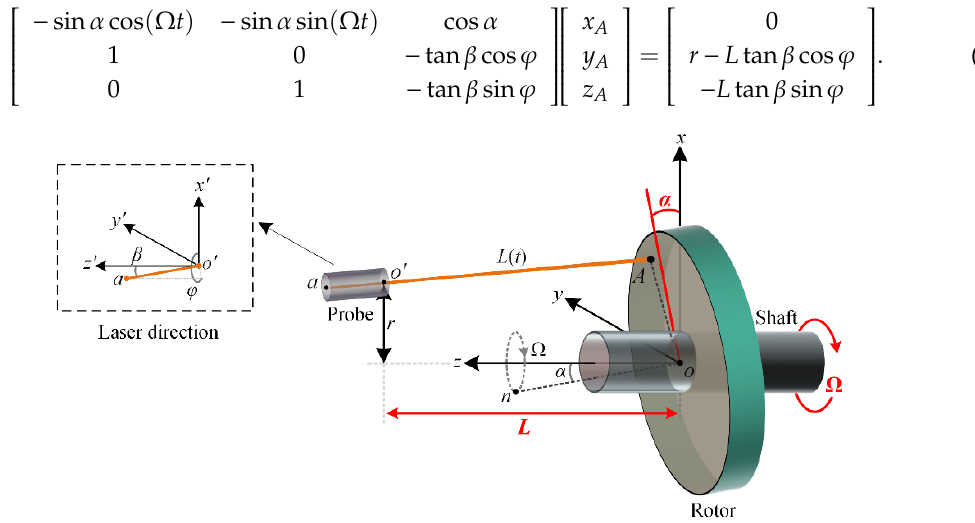
Figure 3. Schematic of the multi-parameter measurement of the rotor.